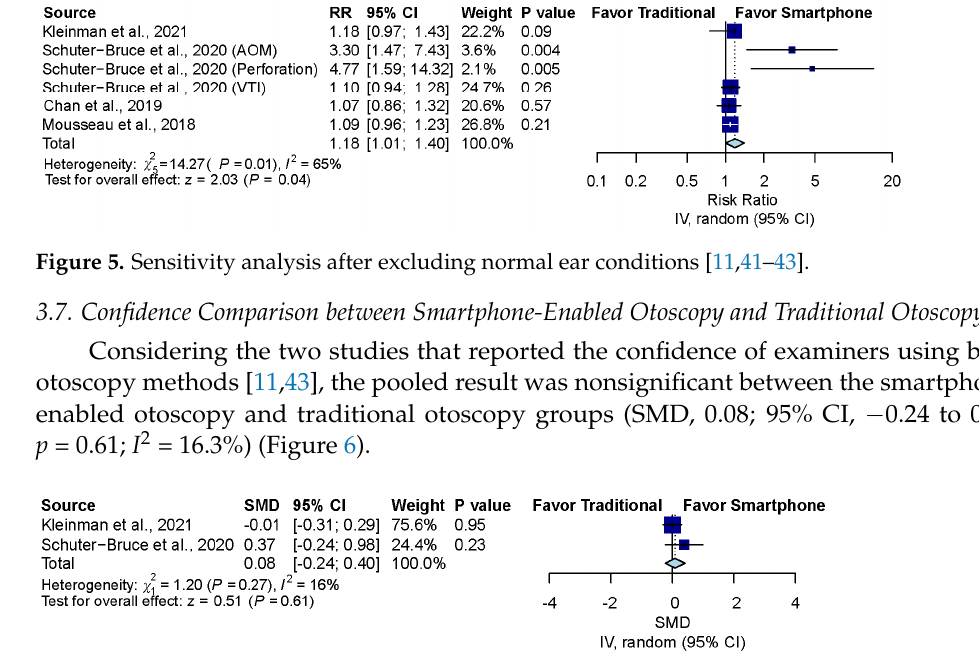
Figure 6. Confidence comparison between smartphone-enabled otoscopy and traditional otoscopy [11,43].